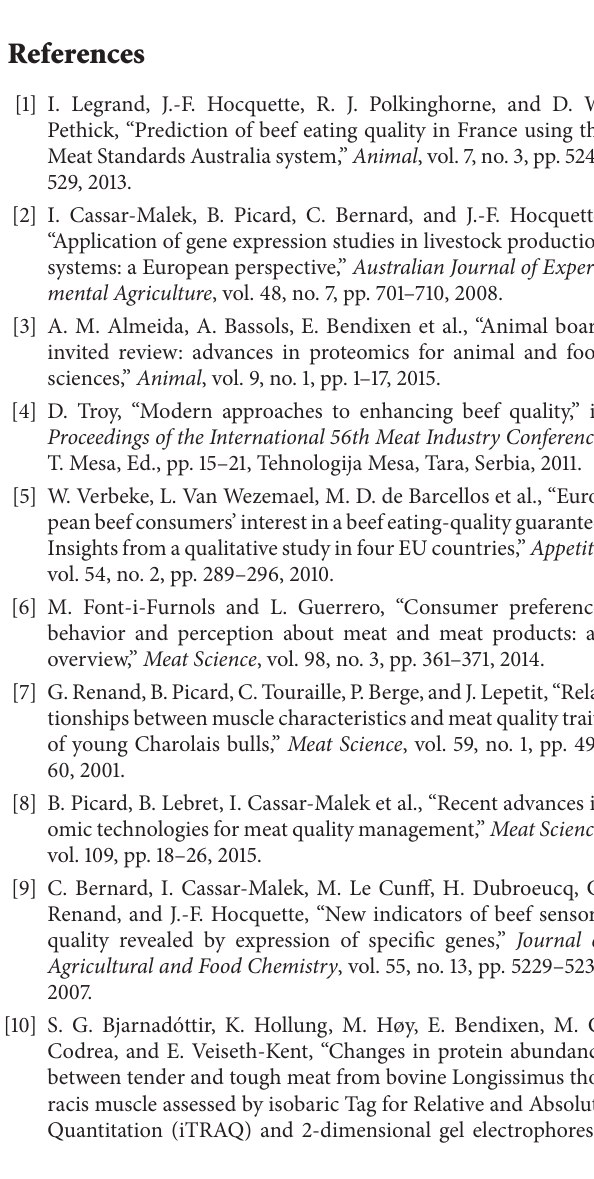
Figure 4: Expression marker-based tools for the management of sensory quality in the beef production chain. The application of the tools to the live animals or to their carcasses online will be for phenotyping and prediction